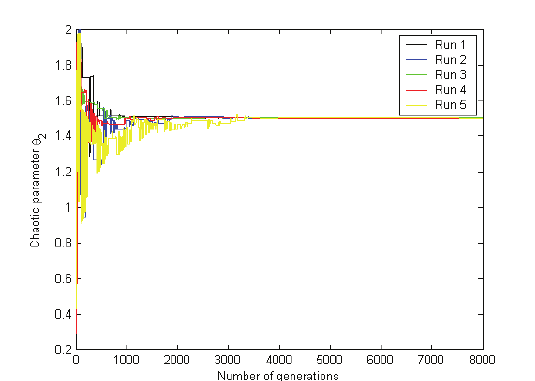
(cid:84) for the first five 2